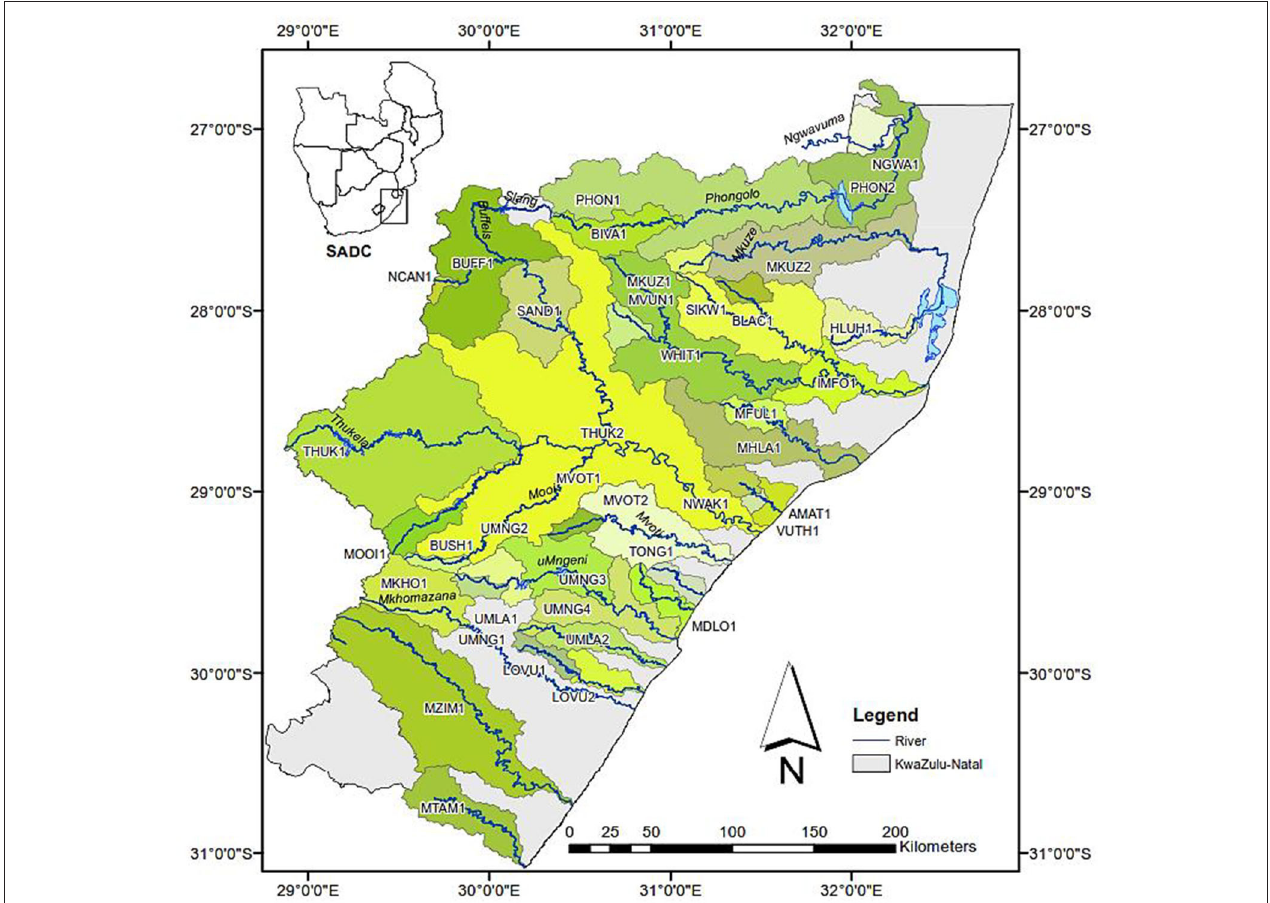
FIGURE 1 | Risk assessment regions of KwaZulu-Natal, South Africa, from 2015 to 2016 [Inset: map of Southern Africa Development Countries (SADC)].